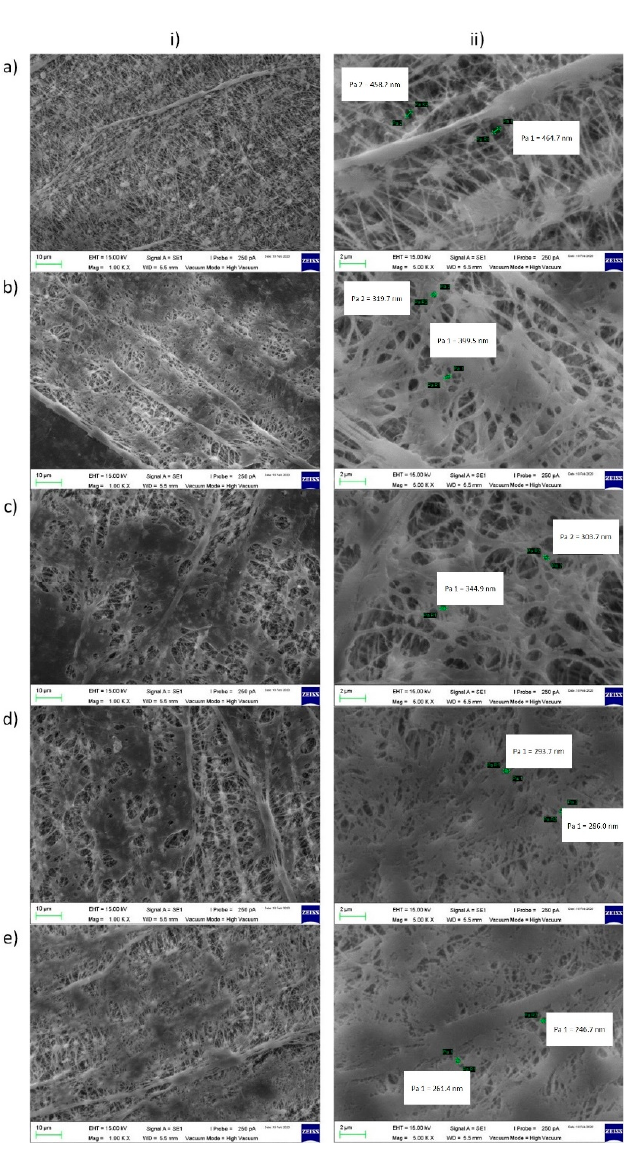
Figure 3. Surface morphologies of ( a ) PEBAX 0, ( b ) PEBAX 0.5, ( c ) PEBAX 1.0, ( d ) PEBAX 1.25, and ( e ) PEBAX 1.5, at ( i ) 1.0 k magnification and ( ii ) 5.0 k magnification.